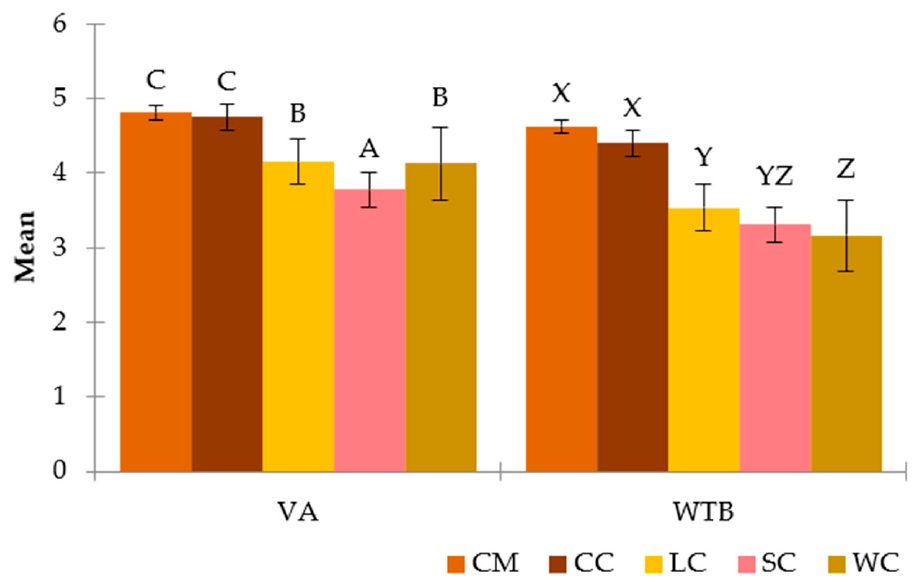
Figure 6. Multiple mean comparisons according to the visual acceptance (VA) and willingness to buy (WTB) for each cake. The different capital letters on columns indicate the significantly different groups according to Tukey’s test: WC, Walnut cake; LC, Leonor cake; SC, Saffron cake; CC, Coulant cake; CM, Chocomuffin.